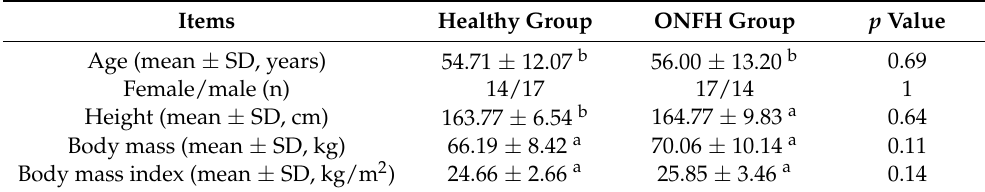
Table 1. Demographics of subjects with osteonecrosis of the femoral head (ONFH) and healthy subjects.